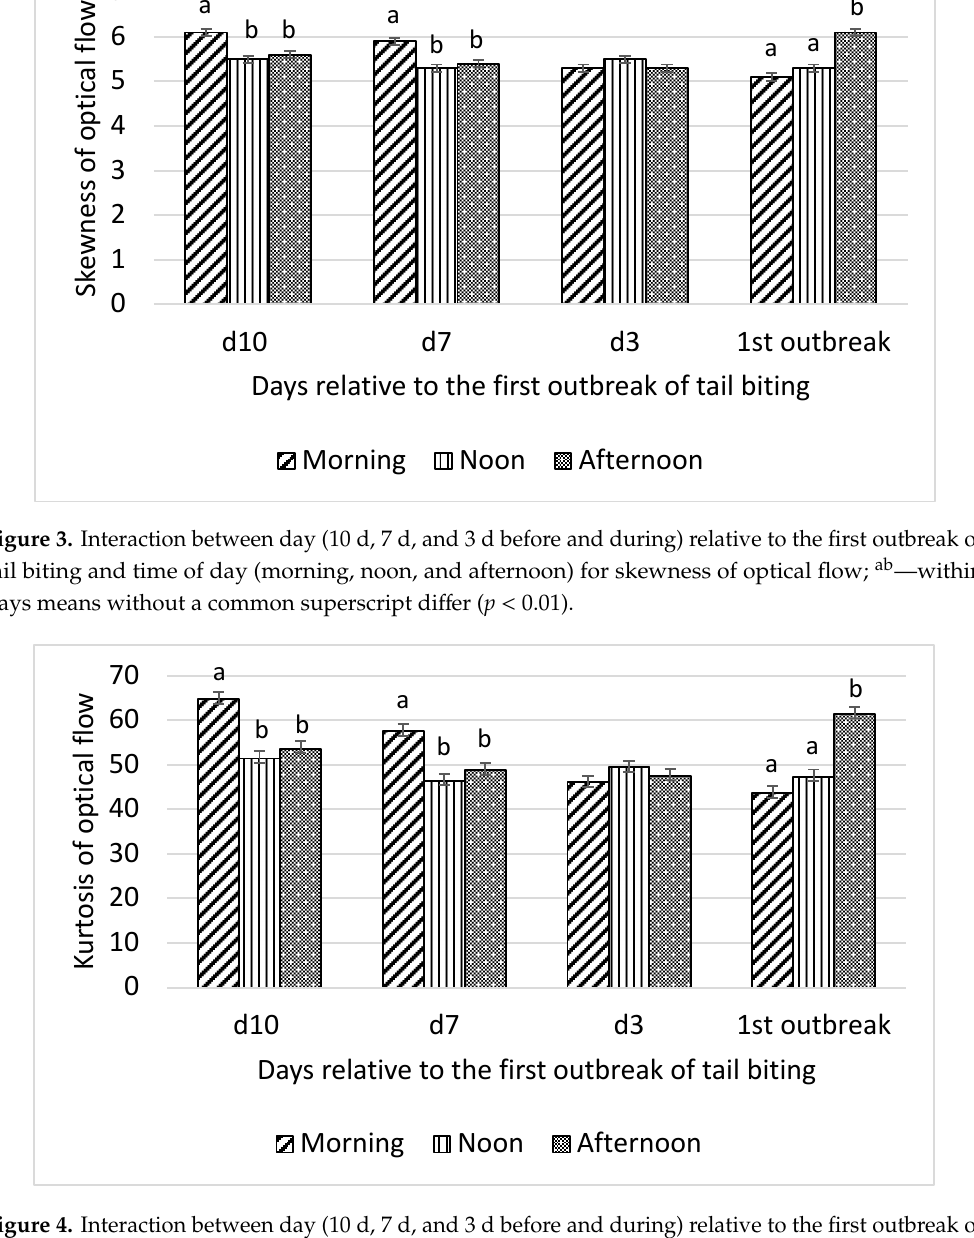
Figure 4. Interaction between day (10 d, 7 d, and 3 d before and during) relative to the first outbreak of tail biting and time of day (morning, noon, and afternoon) for kurtosis of optical flow; ab —within days means without a common superscript differ ( p < 0.01).